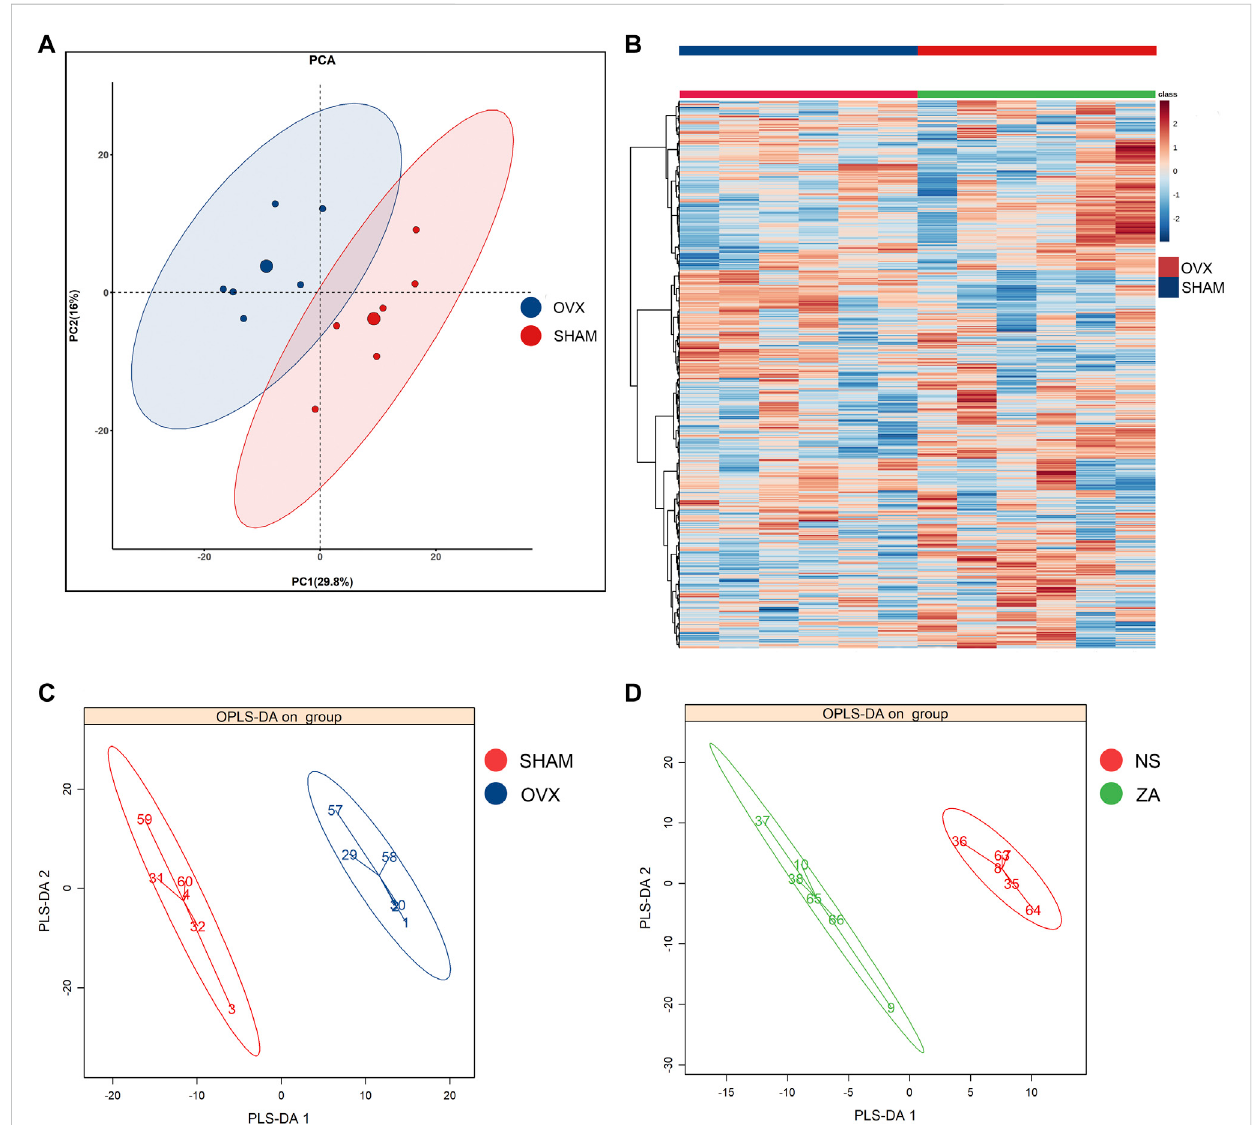
Multivariate statistical analysis of metabolic pro fi le. (A) PCA score plot of OVX versus SHAM at week 0; (B) heatmap of metabolites in OVX versus SHAM at week 0; (C, D) OPLS-DA score plot of OVX versus SHAM at week 0 and ZA versus NS at week